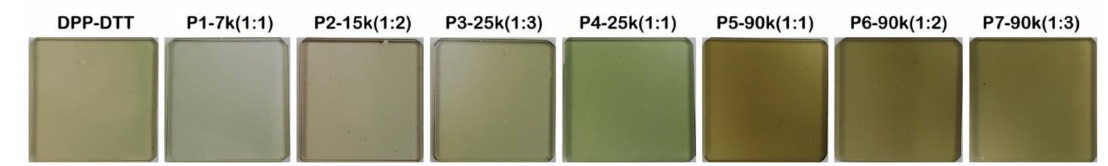
Figure 1. Photographs of thin films based on the DPP-DTT:C60 blends deposited by MAPLE on glass substrate.